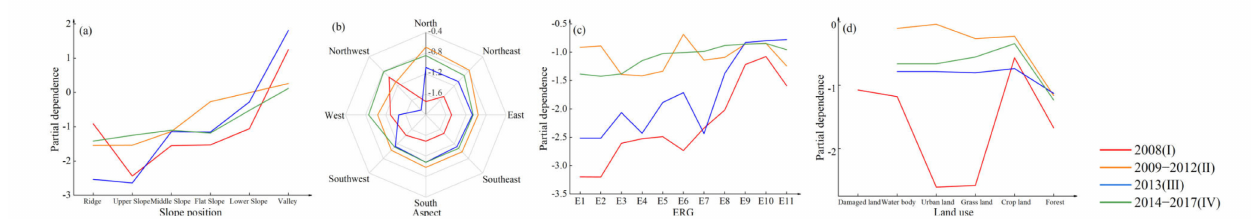
Figure 10. Partial dependence plot in category factor: ( a ) slope position; ( b ) aspect; ( c ) ERG (E1 is extrusive rock; E2 is solum; E3 is intrusive rock; E4 is carbonate rock; E5 is fine-coarse clastic rock; E6 is fine-medium clastic rock; E7 is carbonate rock intercalated clastic rock; E8 is metamorphic rock; E9 is fine clastic rock; E10 is clastic rock intercalated carbonate rock; and E11 is metamorphic rock intercalated carbonate rock); and ( d ) land